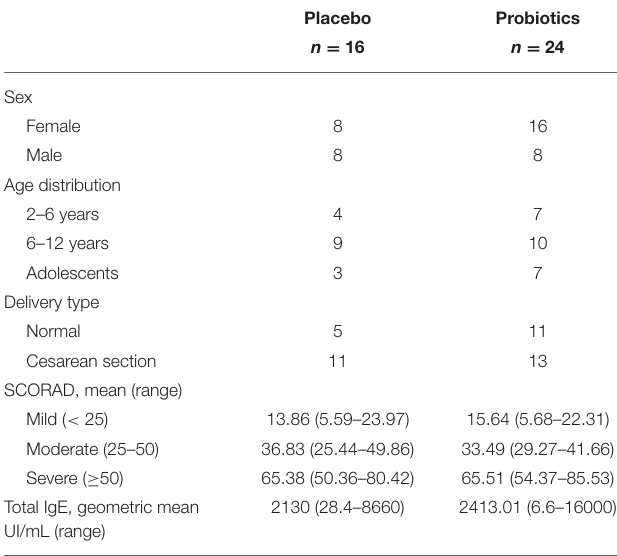
TABLE 1 | Demographic characteristics of patients, per random group